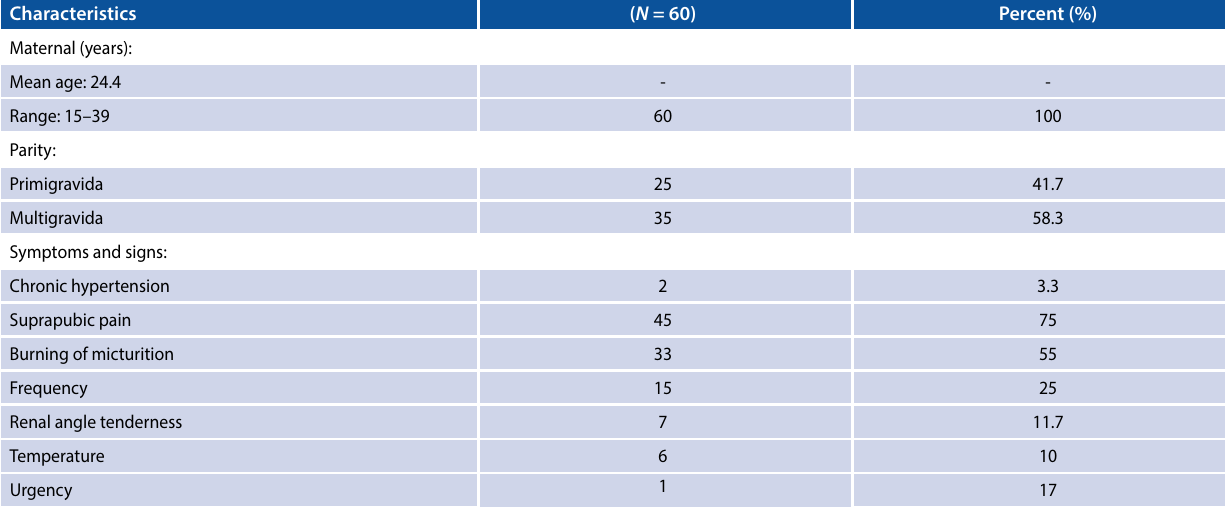
Table 2: Medical and/or obstetric complications and results of investigations